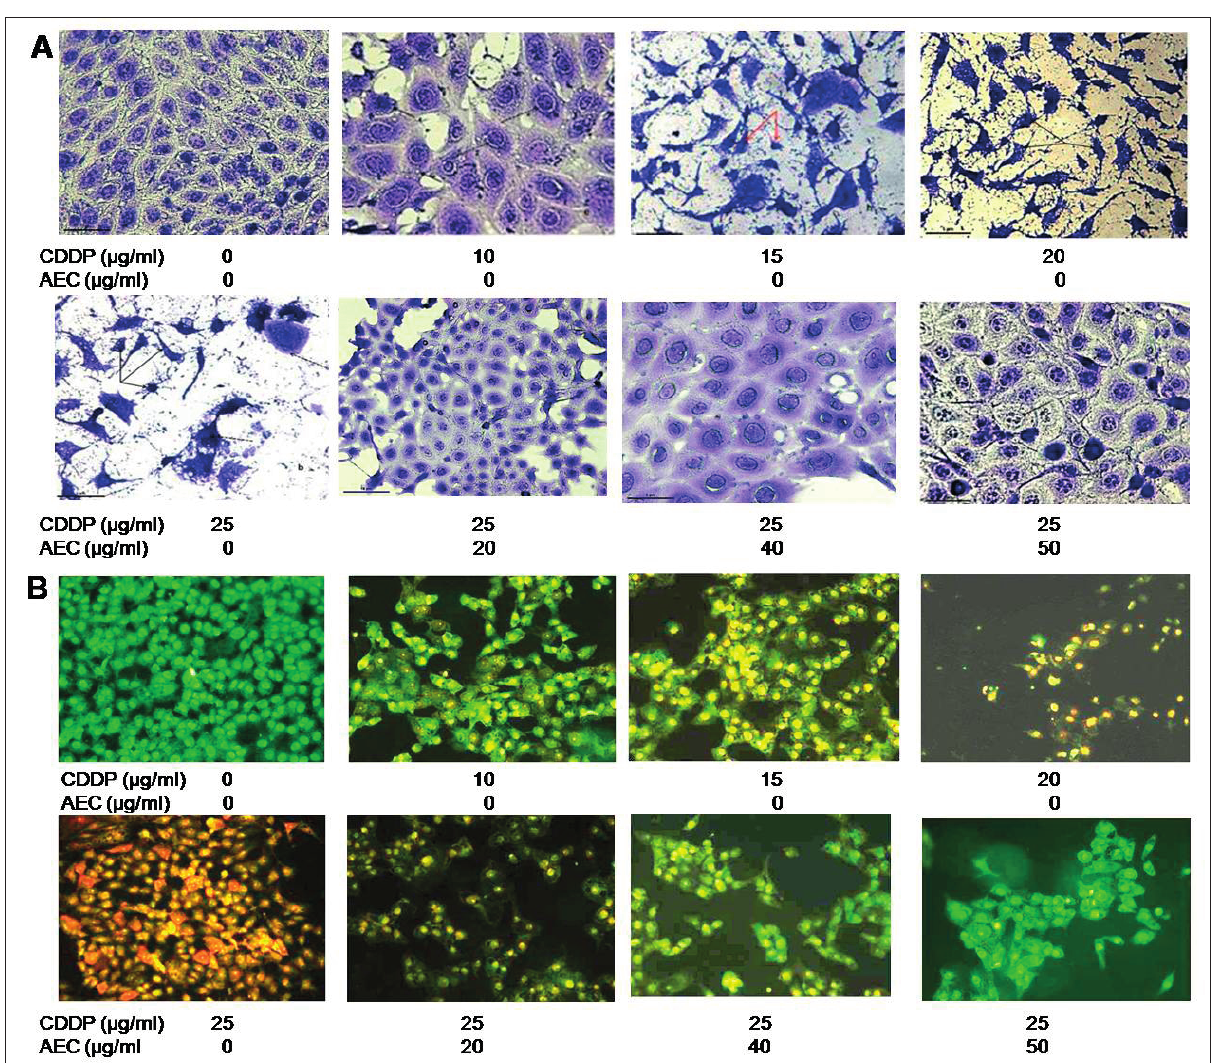
Fig. 2. aec prevented cddp-induced apoptotic cell death. (a) light microscope images displaying cells fixed in formalin- buffered phosphate and stained with coomassie blue; notice gradual alteration of cell shapes as a result of increasing doses of cddp. These include cellular, irregularity of cell shape and blebbing of cell membrane, condensation of chromatin, formation of apoptotic bodies (red & black arrows) and late apoptosis/secondary necrosis; magnification 20x. (B) cells were stained with vital stain (ao/etBr) for 15 min at 37 °c and visualized by florescent microscope. Note, treatment with induced apoptotic signs in Vero cells and including aec with cddp abrogated apoptotic signs induced by cddp; magnification